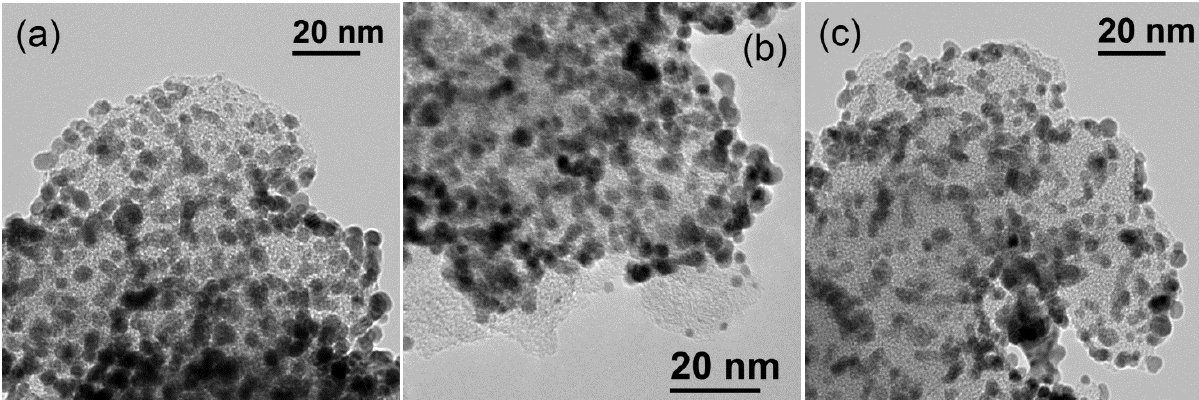
Figure 10. Representative TEM micrographs of the various electrocatalysts ( a ) Pt/CX-4-